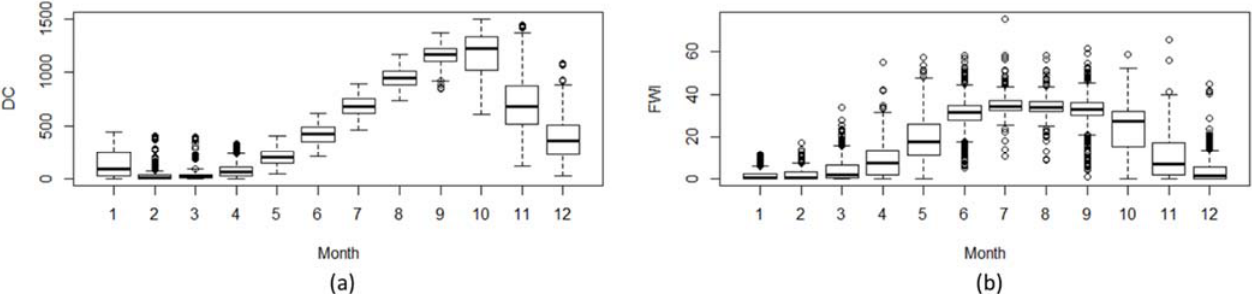
Figure 8. Median, standard deviation, 95% confidence interval, and outliers of monthly values of ( a ) DC and ( b ) FWI in Lebanon for the period 2001–2020.